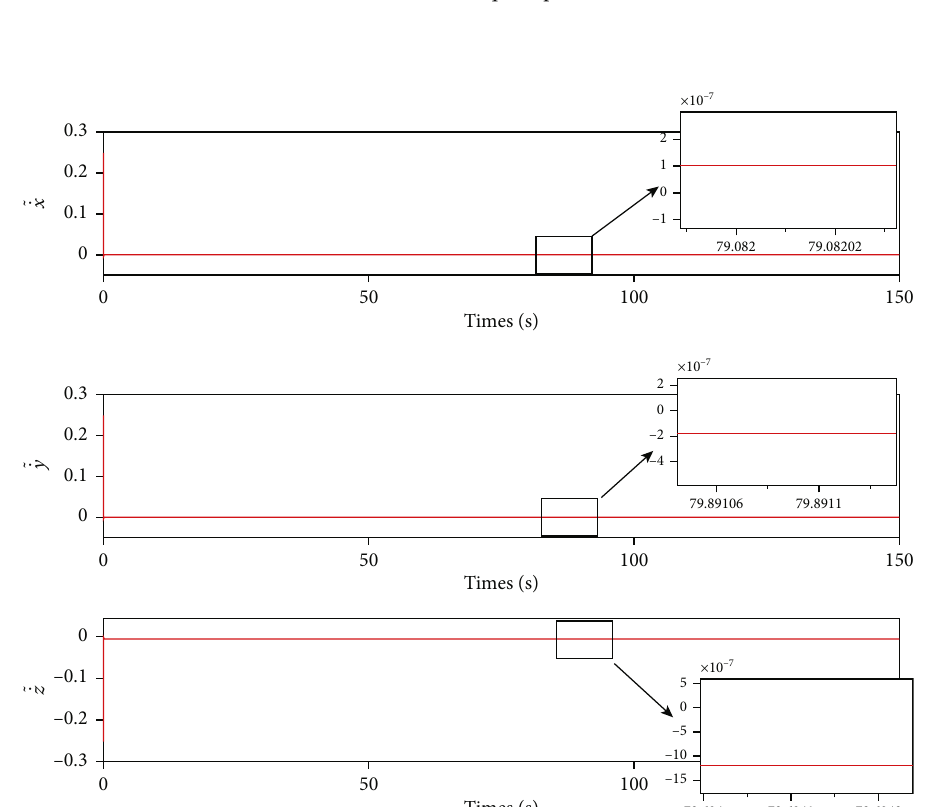
Figure 13: Torque inputs.